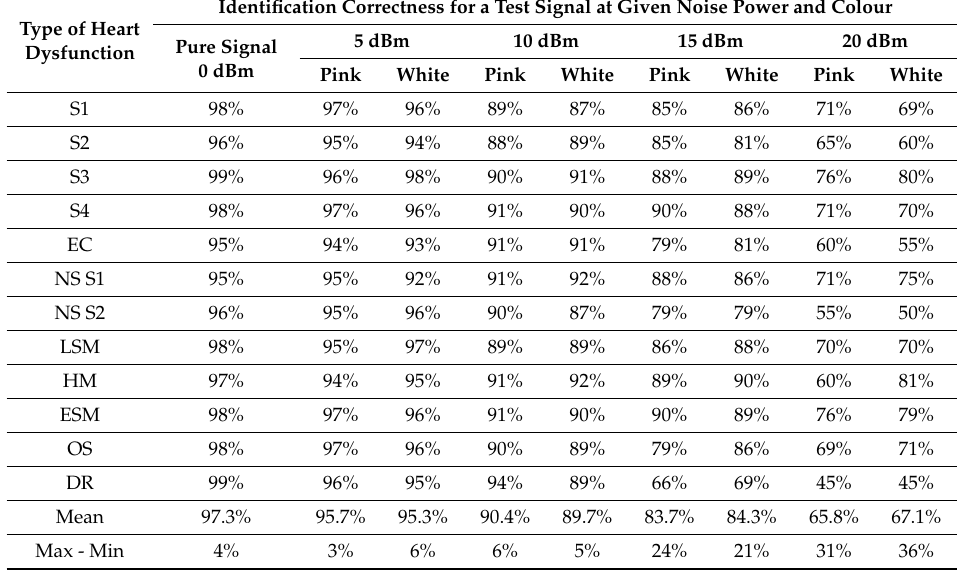
Table 3. The impact of the WT-TDNN denoising on the identification accuracy of LPC-NN classifier. Identification Correctness for a Test Signal at Given Noise Power and Type of Heart Dysfunction